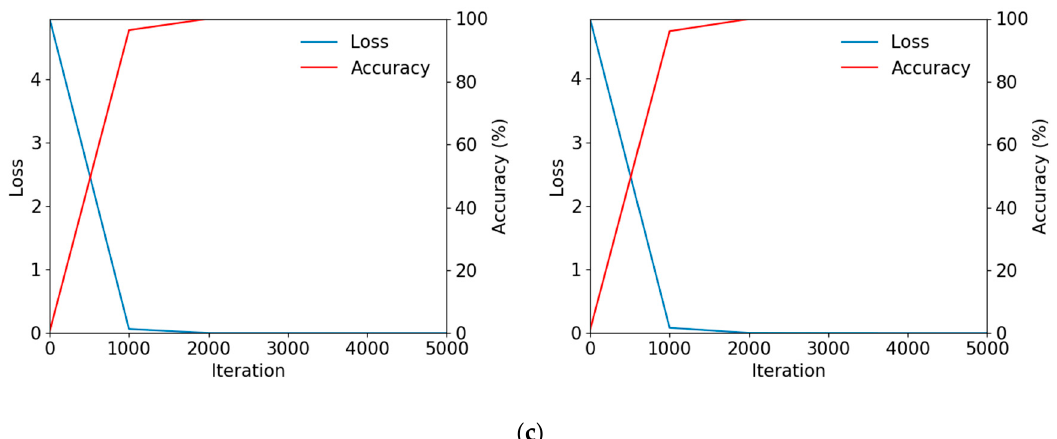
Figure 7. Examples of training loss and accuracy graphs with CASIA-Iris-Distance database. Left and right figures are the graphs of DB1 and DB2 training, respectively. Graphs of training by ( a ) ResNet-50, ( b ) ResNet-101 and ( c ) ResNet-152 models, respectively.